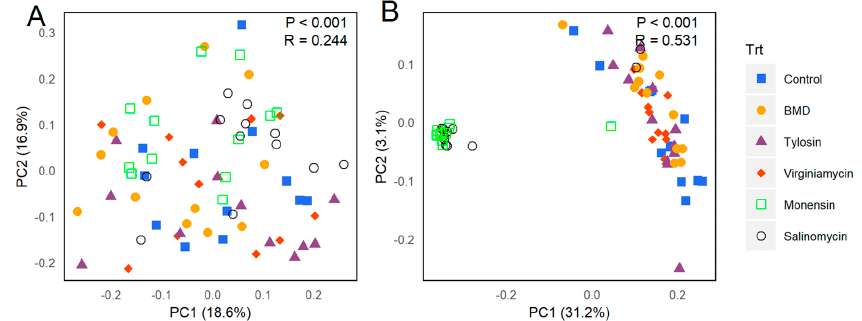
Figure 2. The β -diversity of cecal microbiota of broilers following 2-week supplementation of different antimicrobials. Principal coordinate analysis (PCoA) plots were generated from 12 samples of each treatment using Bray–Curtis ( A ) and Jaccard indices ( B ), respectively. Statistical significance and R values were determined using analysis of similarity (ANOSIM) and indicated in each plot. Table 1. Pairwise comparisons of different antimicrobials on β -diversity of the cecal microbiota using the ANOSIM analysis.